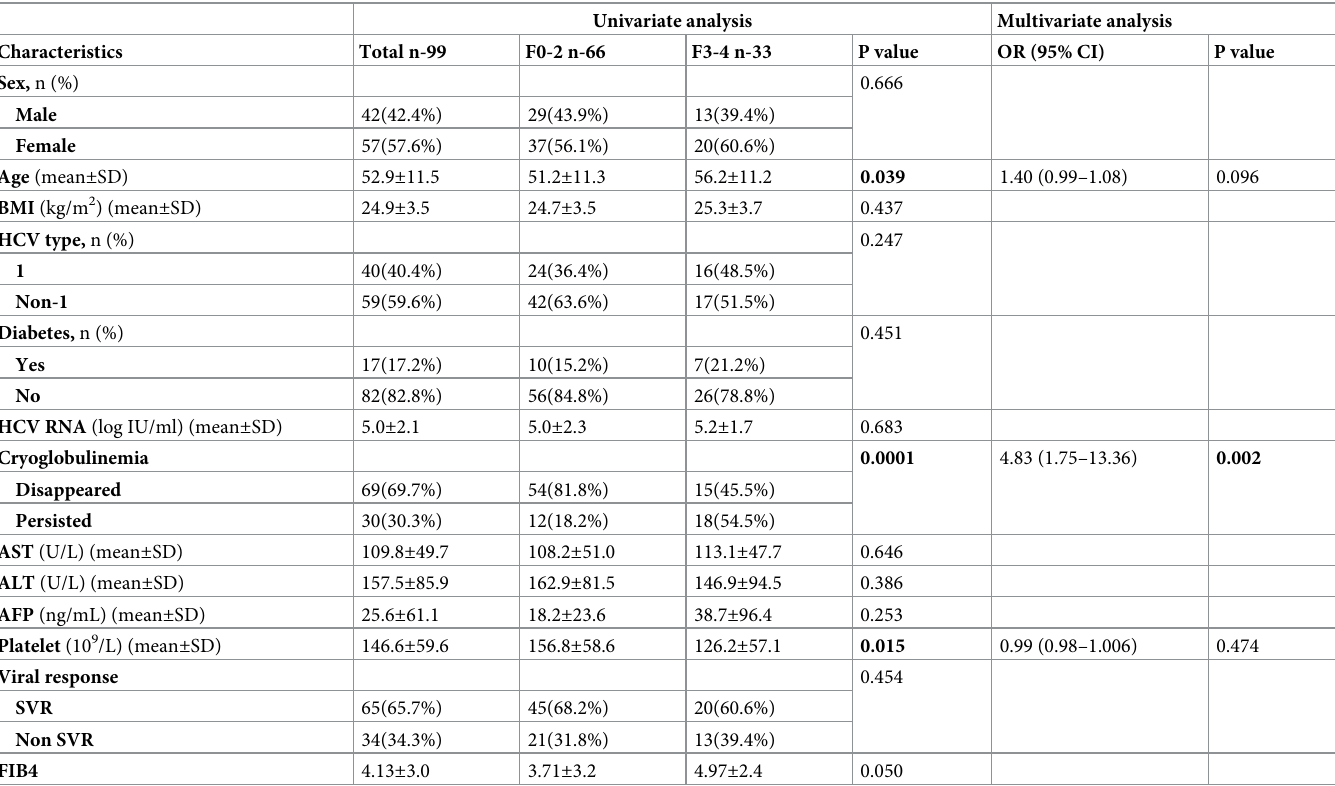
Table 4. Univariate and multivariate analysis of the factors associated with advanced fibrosis in patients with follow up after antiviral therapy. Univariate analysis Multivariate